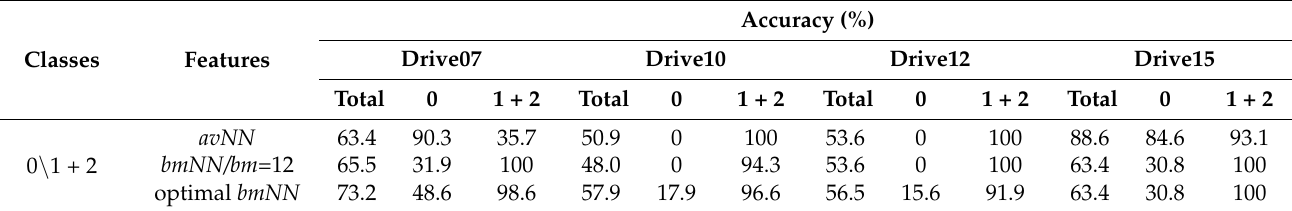
Table 4. Classification results of Drive07 \ 10 \ 12 \